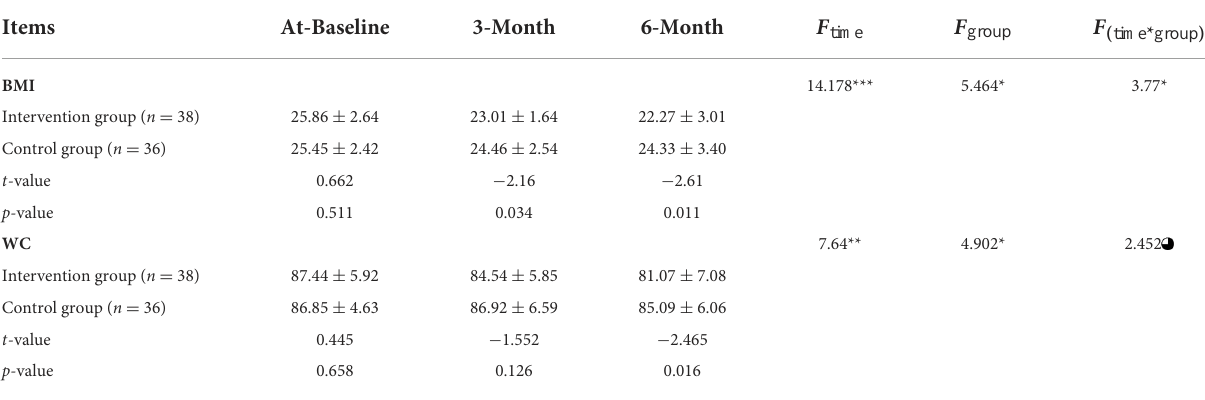
TABLE 3 Comparison of BMI and WC at baseline, third, and sixth